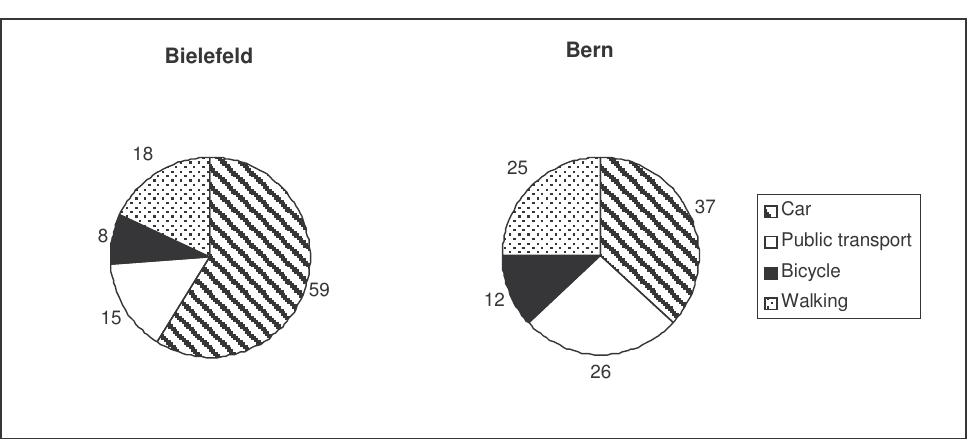
Figure 1. Modal Split in Berne and Bielefeld (1994). All trips of the local population,